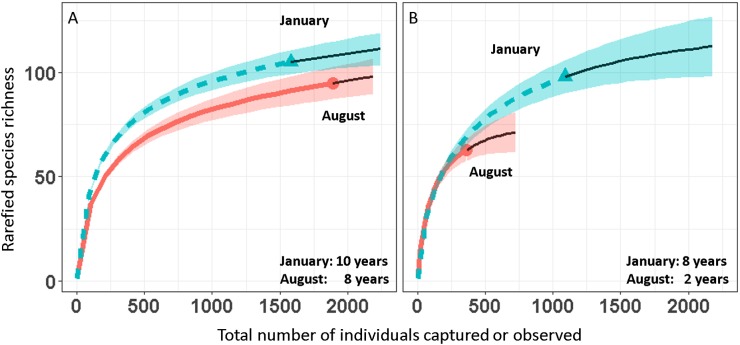
Avian species-accumulation curves for mist-nets (A) and point counts (B).Data are pooled abundances from three secondary forest fragments in Coto Brus, Costa Rica sampled from 2005–2014. Error bands represent 95% CI. Solid black lines represent extrapolated richness.